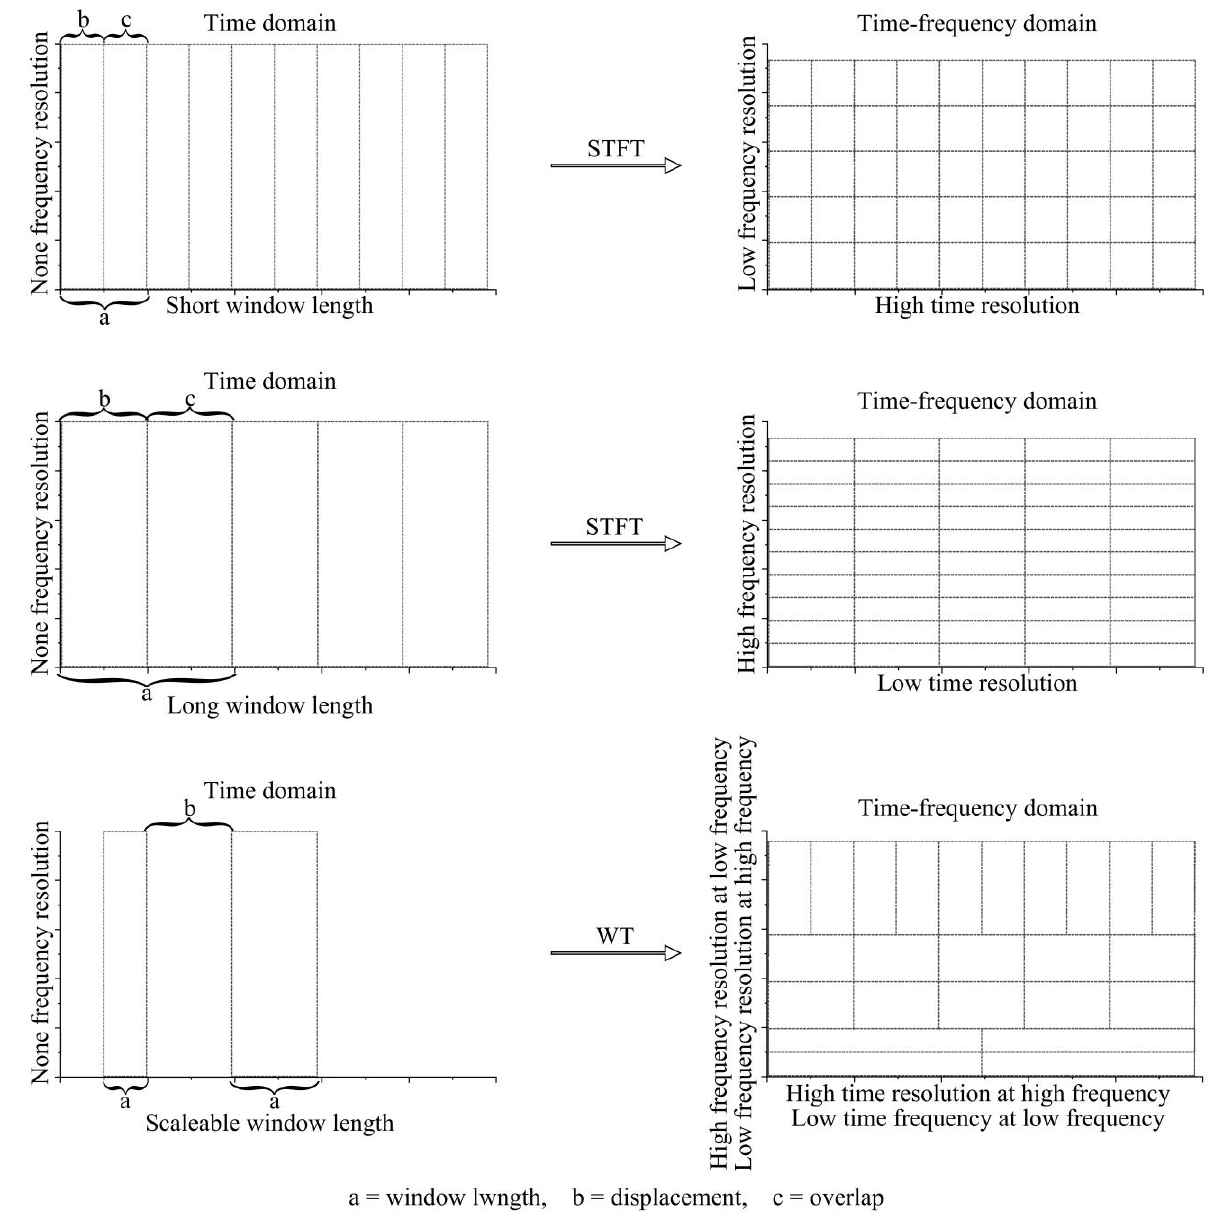
Figure 3. Resolutions of STFT and WT.